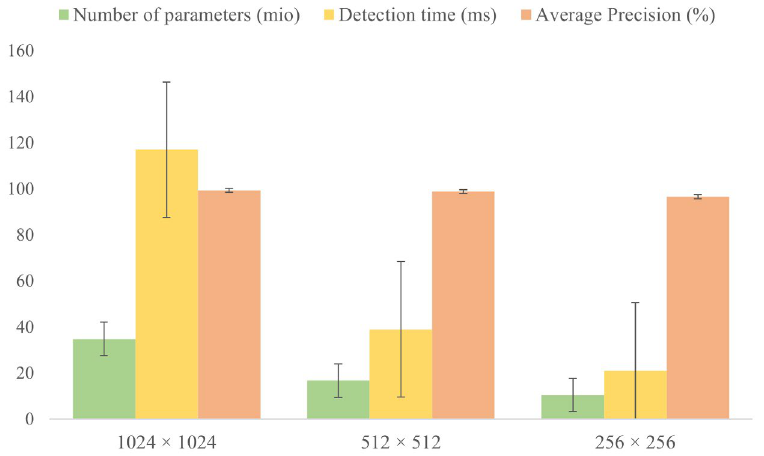
Figure 12. The parameter amount of the model at different image resolutions, the detection time, and the average precision.